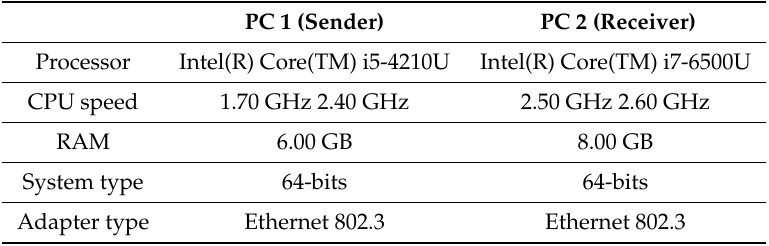
Table 1. Devices properties.